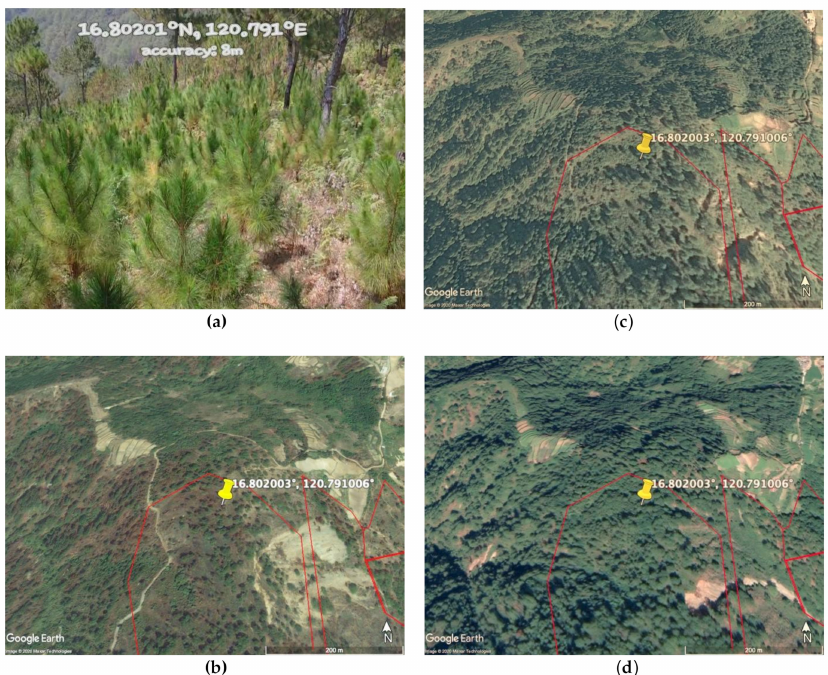
Figure 14. ( a ) Geotagged photo of the NGP site in Cordillera and corresponding VHR RGB images taken on ( b ) 22 April 2010; ( c ) 6 January 2014; and ( d ) 29 November 2018, and accessed through Google Earth Pro. Pin location: 16.802003 ◦ , 120.791006 ◦